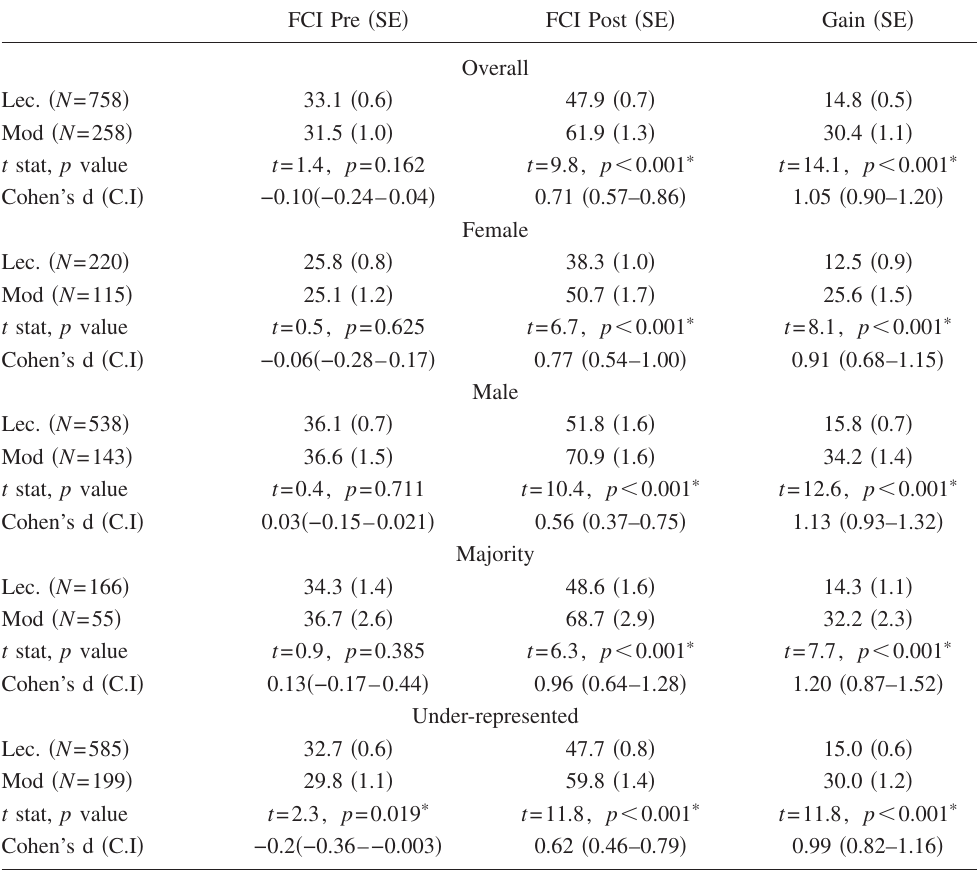
TABLE I. Comparison of Students in Lecture-format and MI Introductory Physics on Force Concept Inventory Disaggregated by Gender and Ethnic Representation.